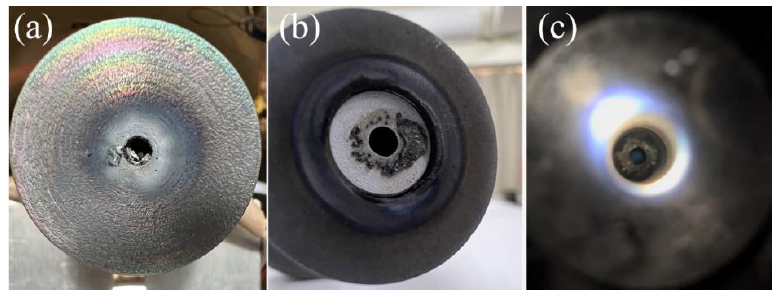
Figure 14. Critical components of C12A7 hollow cathode after discharge at high current. ( a ) The keeper plate. ( b ) Cathode orifice plate. ( c ) Internal area of cathode tube.